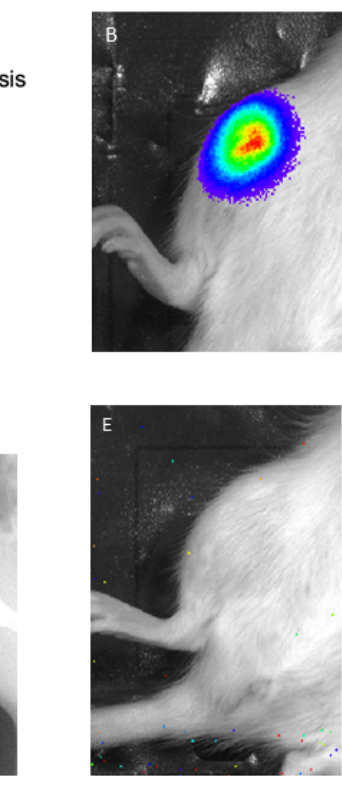
Figure 6. Correlation between relative bone density and bioluminescence signal. ( A ) Animals without bioluminescence signal all had high relative bone density (blue), whereas animals with high bioluminescence signal demonstrated low relative bone density (black). Examples of osteolytic ( C ) and non-osteolytic bone ( D ). Examples of high bioluminescence signal ( B ) and lack of signal ( E